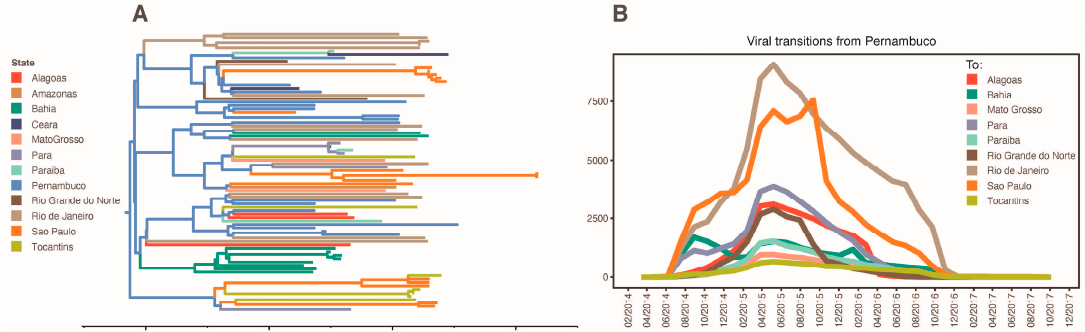
Figure 3. Spatiotemporal reconstruction of ZIKV in Brazil. ( A ) MCC tree of ZIKV genomes isolated in Brazil. Branches are colored according to the state reconstructed in the phylogeographic analysis. ( B ) Supported (BF > 3.0) ZIKV lineages transitions, as calculated by Markov’s jumps, from Pernambuco to other Brazilian